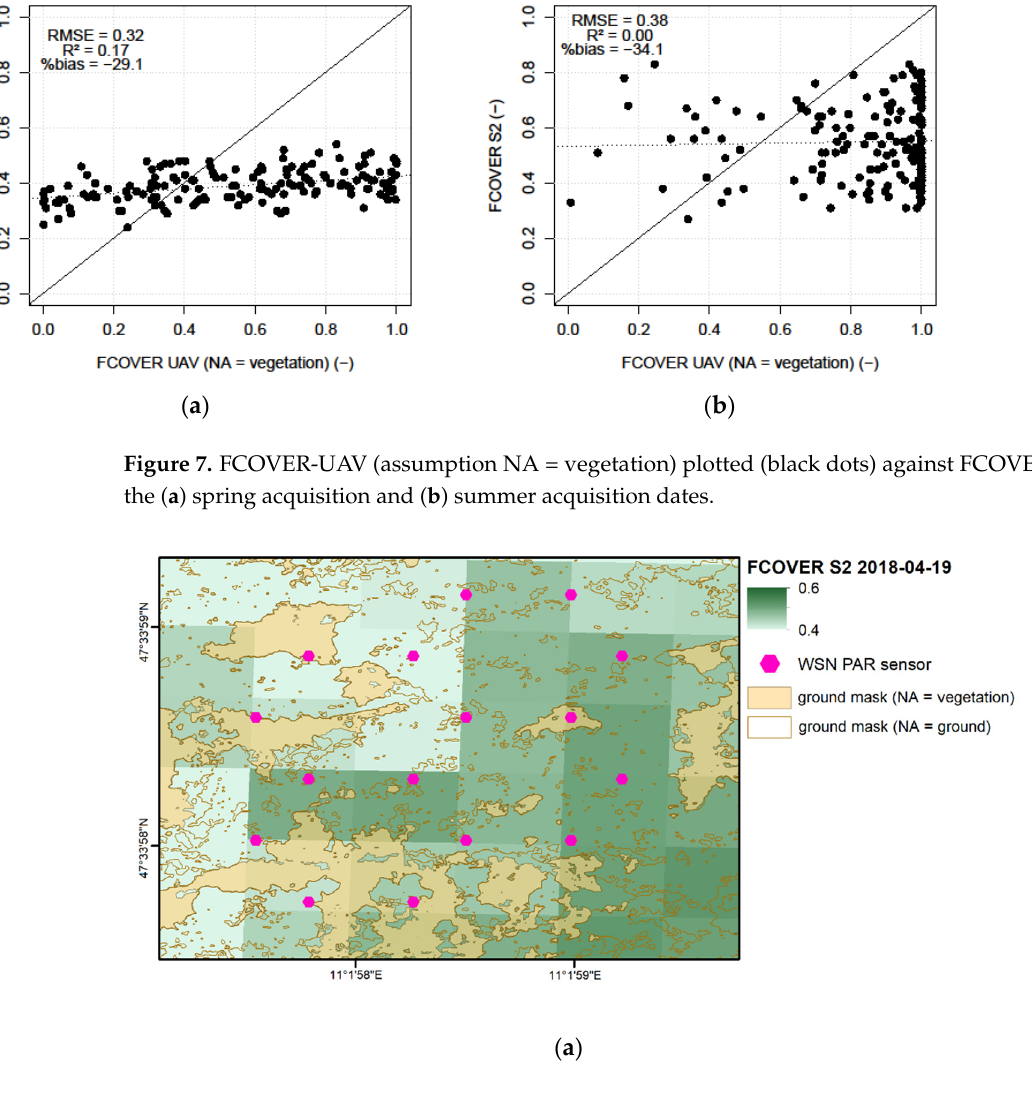
13 of 28 Figure 6. FCOVER-S2 plotted (black dots) against FAPAR-S2 across the study site in the spring ( a ) and summer ( b ). 3.1.3. Evaluation of FCOVER-S2 with FCOVER-UAV To quantify the level of agreement between FCOVER-S2 and FCOVER-UAV, Figure 7 shows scatterplots from the FCOVER calculations from the UAV ground mask based on S2 pixels. While FCOVER-UAV spans over the whole range of values in the spring, FCOVER-S2 ranges from 0.2 to 0.6. In sum, FCOVER-S2 is only around half as FCOVER- UAV, with a mean percent bias ranging from 40% to 50% for the spring and summer ac-